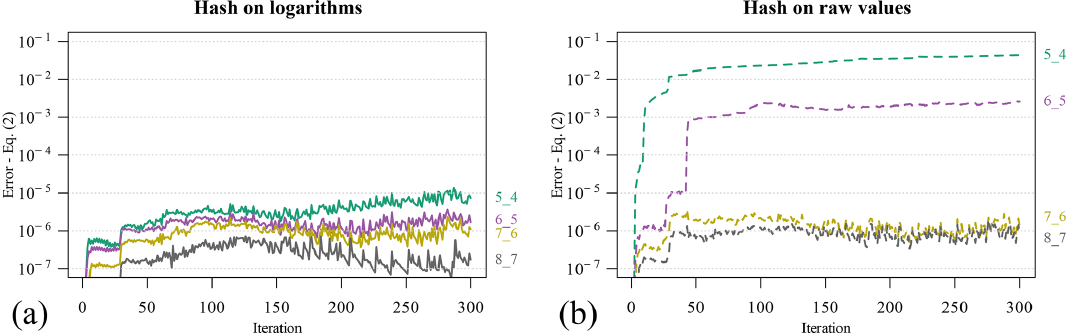
Figure 8. Error as defined by Eq. (2) along the simulations with DHT compared to the reference, as a function of the retained digits for hashing. Colors and labels on the right margin encode the digits used for class 1 and class 2 variables respectively. (a) Logarithm of variables used for hashing; (b) hash taken on raw variables.